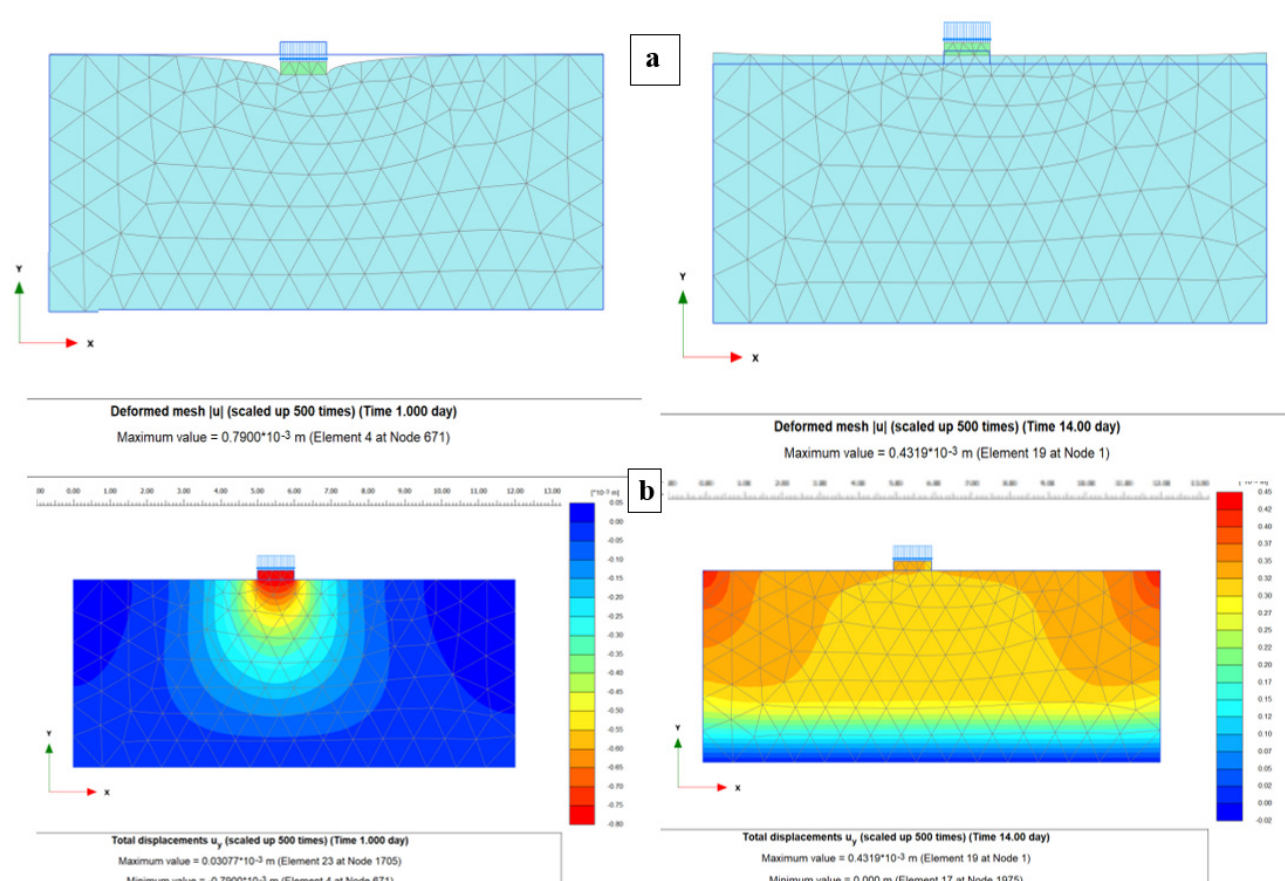
Figure 12. Change of soil water conditions.